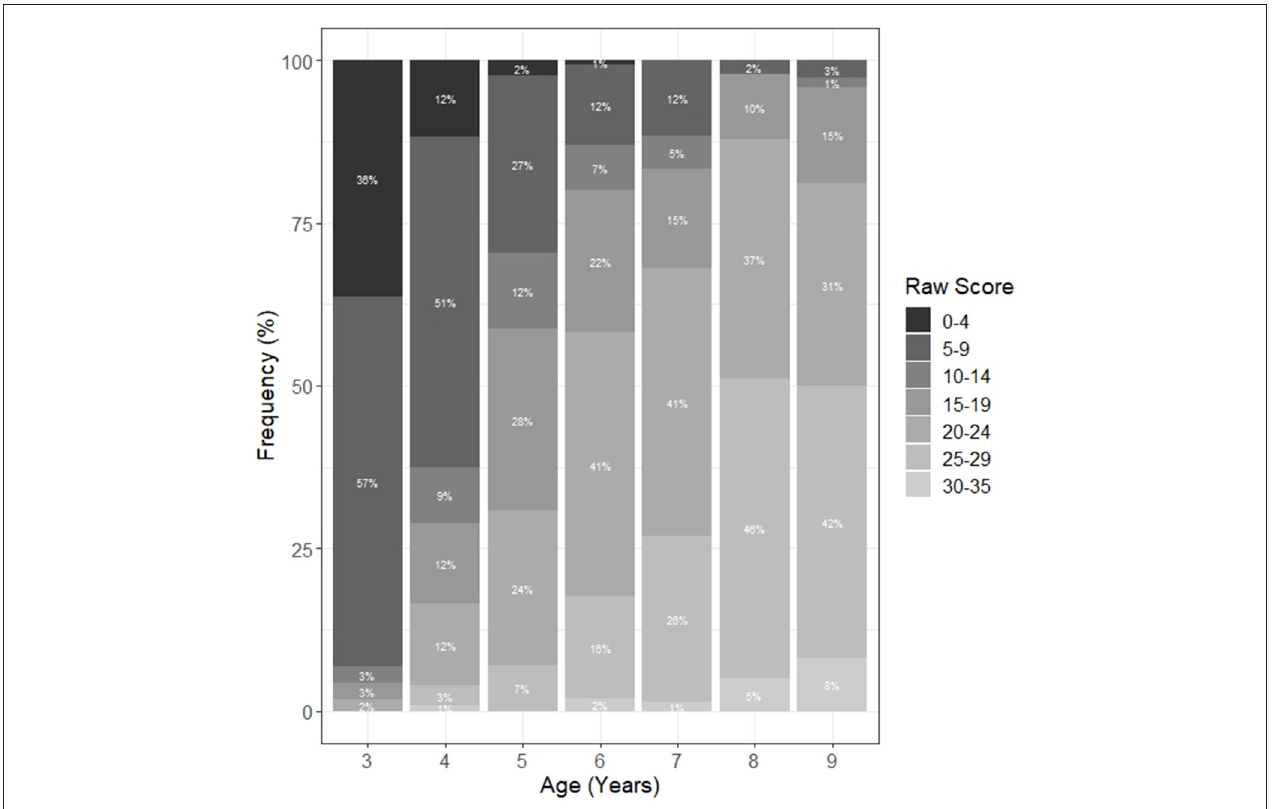
FIGURE 2 | Distribution of the total raw score of the ATEM 3–9 grouped by